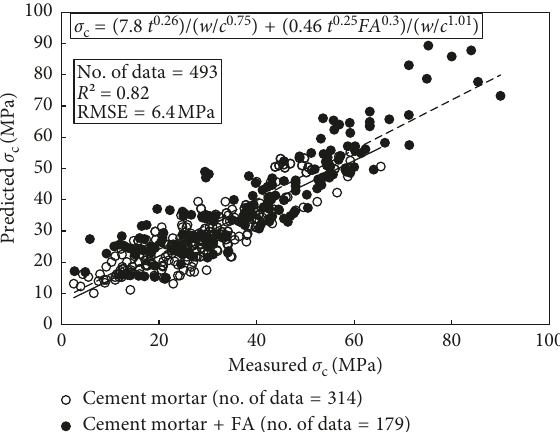
Figure 9: Relationship between measured and predicted com- pressive strengths for cement mortar modified with fly ash (FA).